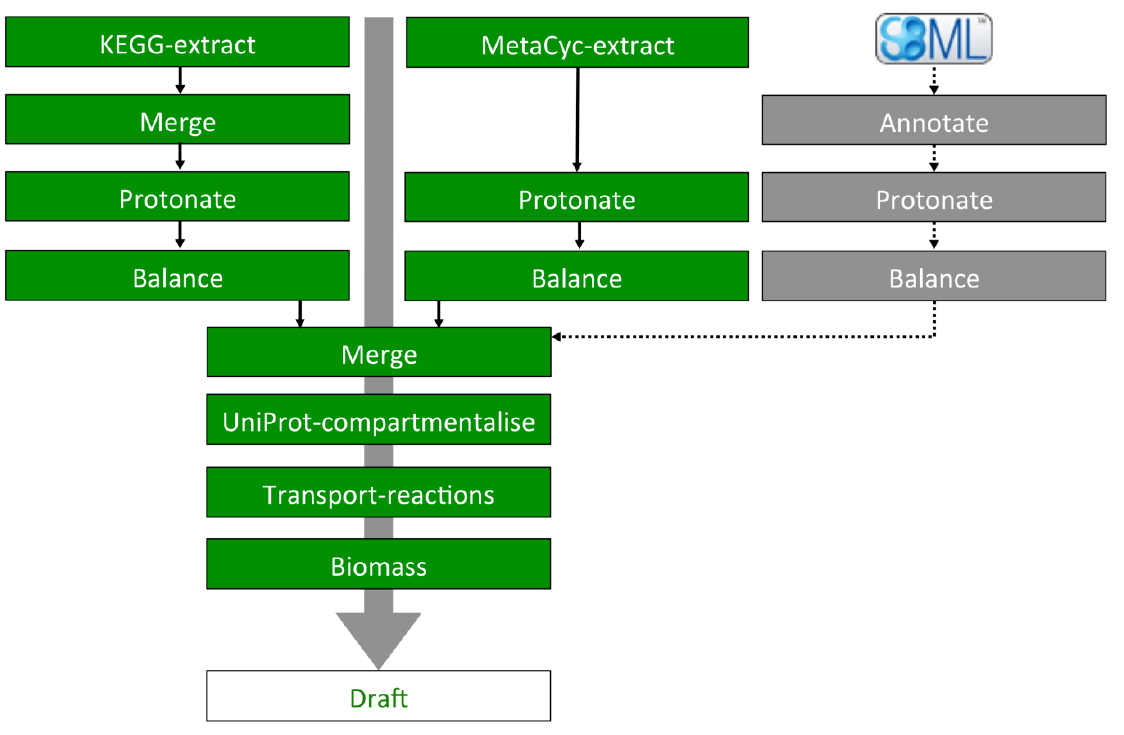
Figure 1: Flow diagram illustrating how SuBliMinaL Toolbox modules may be chained together to generate a draft metabolic network reconstruction that can be analysed in the COBRA Toolbox. The names of the boxes refer to individual SuBliMinaL Toolbox modules. The main branches with solid arrows from KEGG-extract and MetaCyc-extract indicate the pipeline that was utilised in this study. The right-hand branch with dotted arrows indicates a hypothetical addition to the pipeline, which could be used to include existing reconstructions or individual pathways marked up in SBML